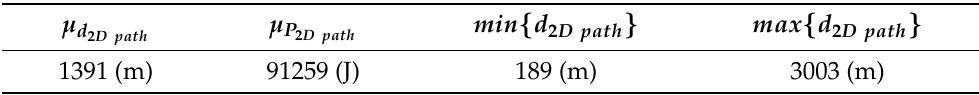
Table 4. Average distance ( d ), power consumption ( P ), and minimum and maximum distances of 2D straight-line paths between start and destination states for the Monte Carlo simulations.